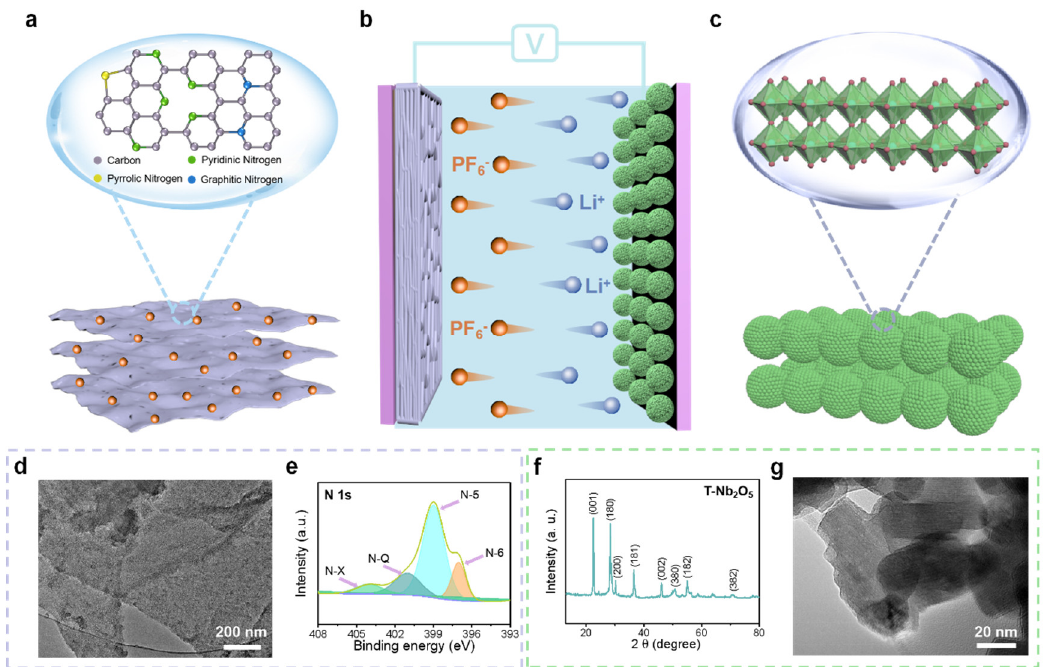
Figure 1. Schematic diagram of the charge storage mechanism for the high-performance lithium-ion capacitor. ( a ) Bonding mechanisms of nitrogen atoms for grafting the carbon networks. ( b ) Schematic diagram of charge transportation. ( c ) Schematic diagram of T − Nb 2 O 5 with a hierarchically spherical structure for anode materials. ( d ) Typical TEM image of N − PC showing the lamellar structure with abundant defects. ( e ) Deconvolution curves of the N1s of N − PC. ( f ) XRD patterns of T-Nb 2 O 5 . ( g ) Typical TEM image of T − Nb 2 O 5 showing the obvious lattice array.